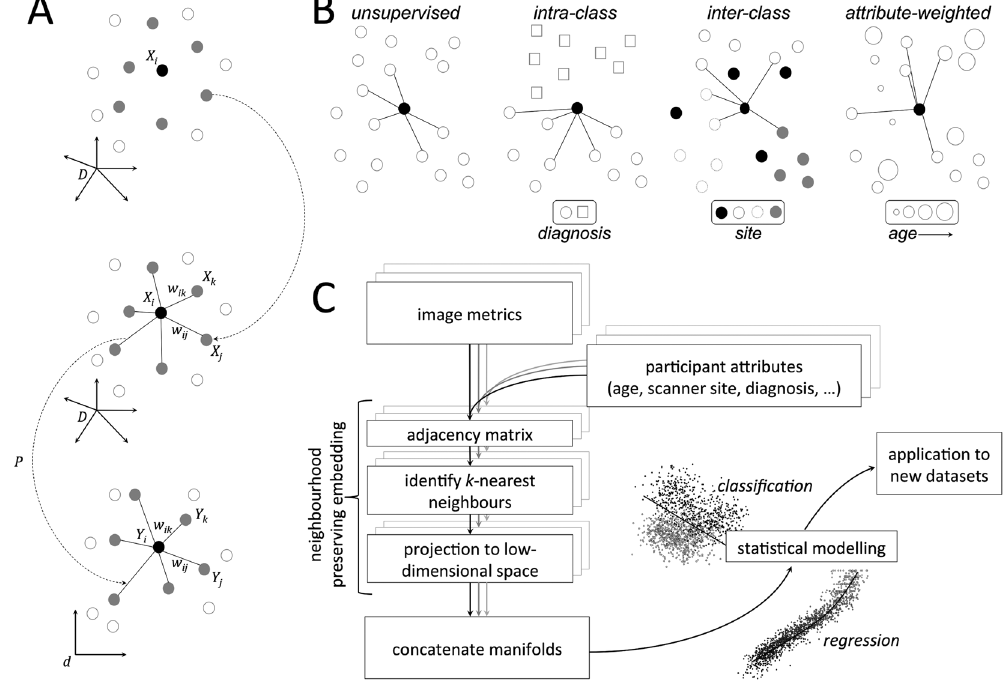
Figure 1. Neighbourhood preserving embedding. ( A ) For a given datapoint, X , nearest neighbours are selected i and weights assigned that can be used to approximately reconstruct X . A linear transformation, P , is then i sought to project the data into a low-dimensional space while preserving the neighbourhood structure. ( B ) Possible supervision strategies for neighbourhood construction. In an unsupervised setting, neighbours are selected based on image similarity alone; alternatively, neighbours can be selected from within- or between- classes in order to maximise/minimise group differences in the manifold structure. Similarly, neighbours can be selected based on the weighted combination of image similarity and that of another subject-specific attribute (e.g.: age). ( C ) Analysis pipeline for NPE analysis. For each image metric, NPE is used for subspace projection, before the embedded data are combined and passed on for statistical